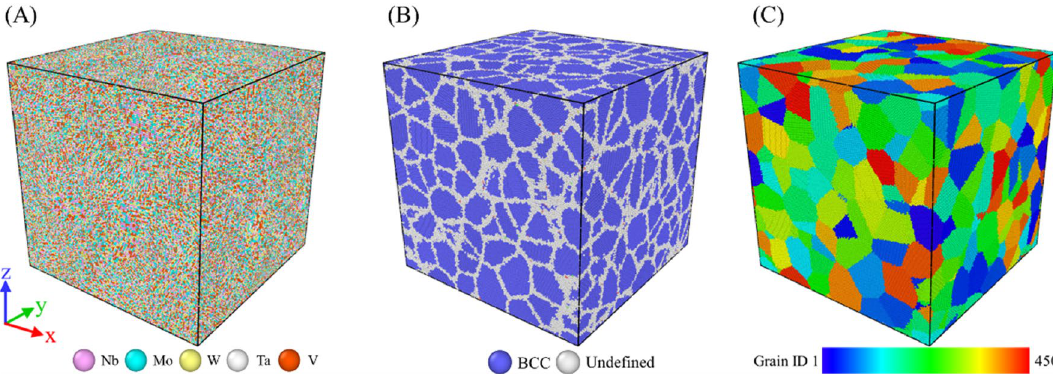
Figure 1. The polycrystalline Nb 20.6 Mo 21.7 Ta 15.6 W 21.1 V 21.0 RHEA model with the average grain size about 5.2 nm for the heating process. The system size is about 40.7, 40.7, and 40.7 nm in the x-, y-, and z-dimensions, respectively. Atoms are colored according to ( a ) the element type, ( b ) grain and grain boundary atoms identified by the common neighbor analysis (CNA), and ( c ) the grain identity number. The current study considers the RHEAs with the average sizes of 25.3, 20.1, 15.6, 10.0, and 5.2 nm.